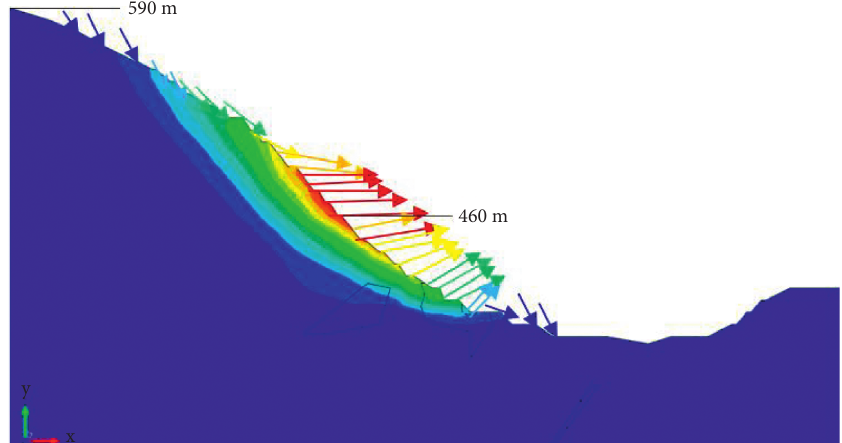
Figure 16: Displacement vector along the rock slope at φ � 40( ° ) in the blue dotted rectangle in Figure 8(b). The arrow indicates the direction of the displacement, whereas the length of the arrow is proportional to the magnitude of the displacement.